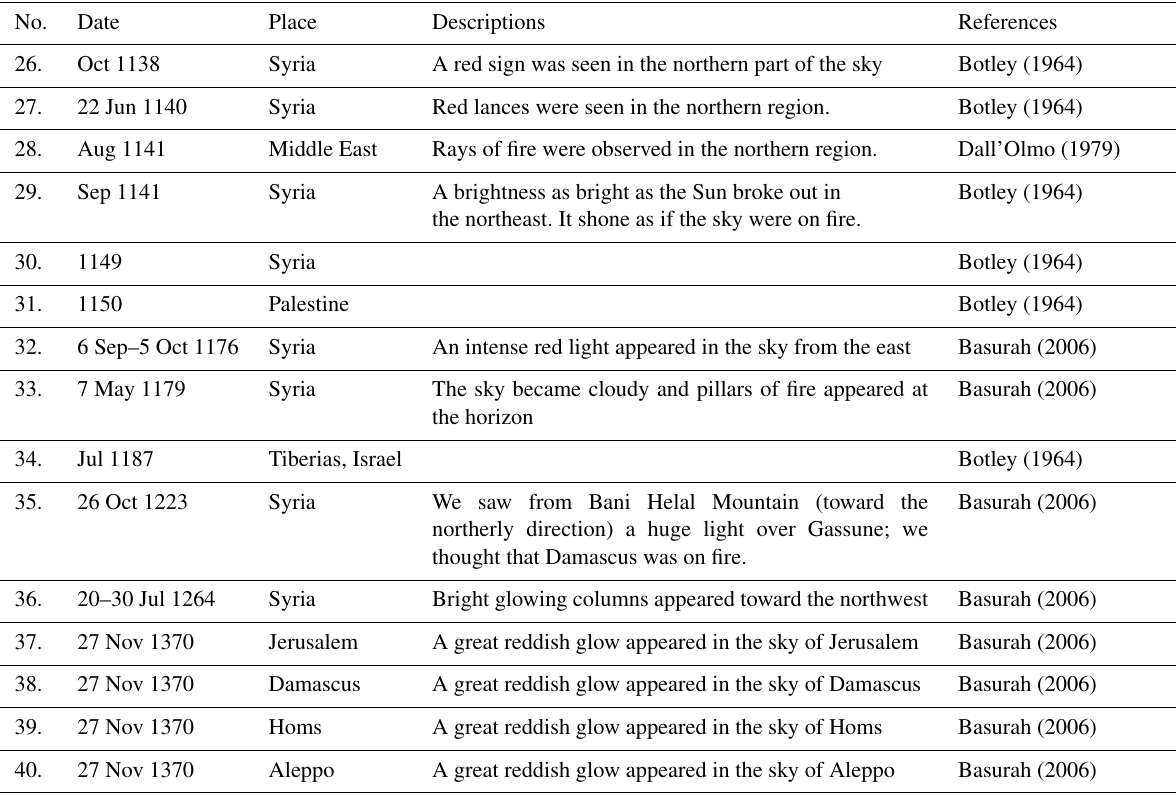
Table 4. Ancient aurora observations recorded in the Middle East region during the Medieval